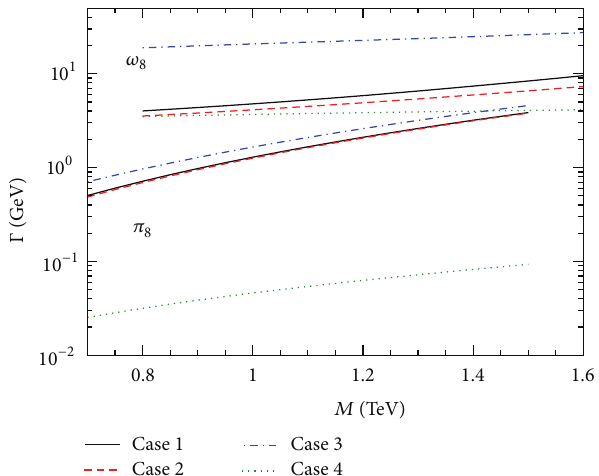
Figure11:Totaldecaywidthof 𝜔 8 and 𝜋 8 forthefourparametersets. The upper curves are for 𝜔 8 , where Case 3 is enhanced by a larger −𝑚 𝑚 𝜔 8 𝜋 8 mass difference. The lower curves, plotted 100GeV less in mass, are for 𝜋 8 , where Cases 1 and 2 are barely distinguishable.